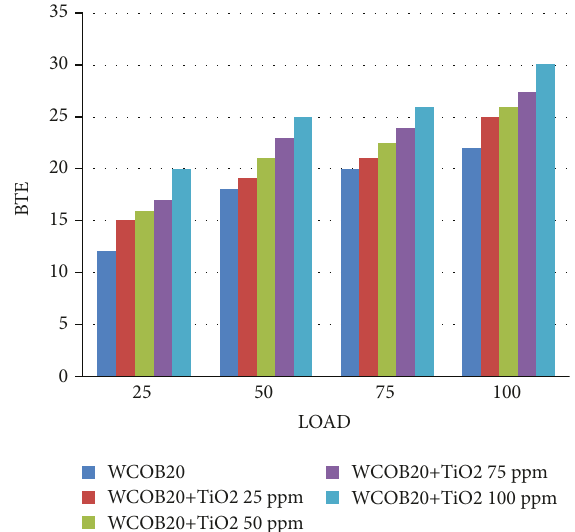
Figure 8: Brake thermal efficiency with respect to